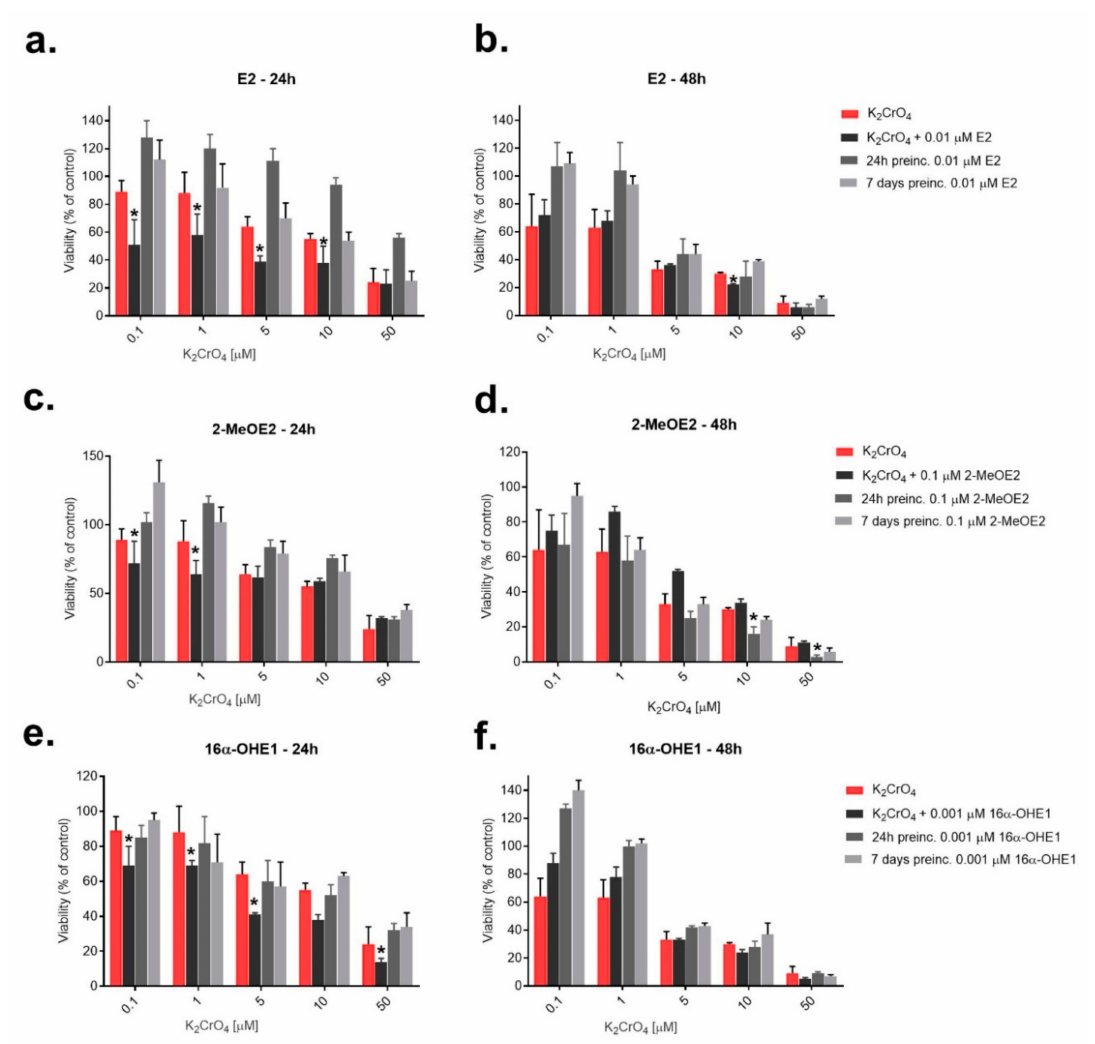
Figure 3. Changes in SKOV-3 viability after 24 h and 7 days of pre-incubation with E2 ( a , b ), 2-MeOE2 ( c , d ) and 16 α -OHE1 ( e , f ), and exposure to potassium chromate (VI), measured by MTT after 24 h and 48 h. The figure also shows the combined action—the interaction of the respective estrogen with potassium chromate (VI) (* statistically significant, p <